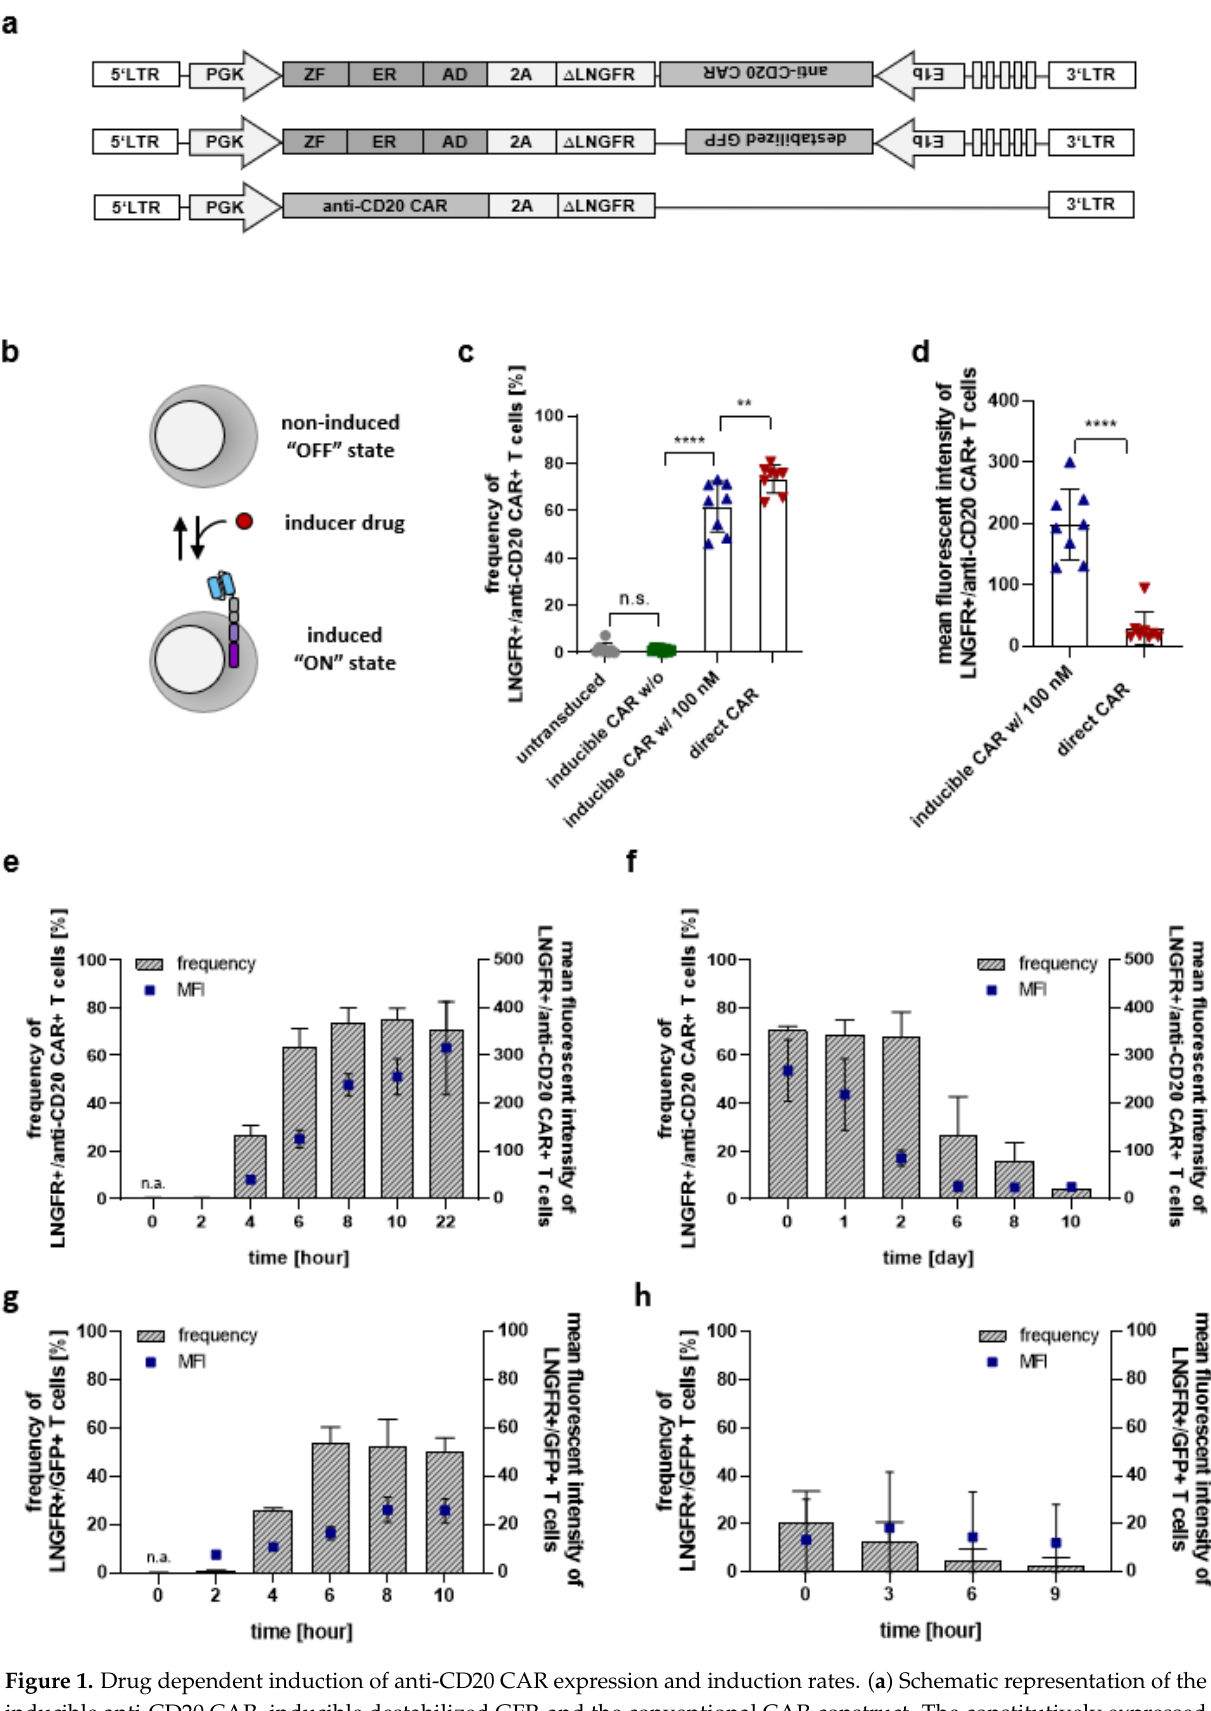
Figure 1. Drug dependent induction of anti-CD20 CAR expression and induction rates. ( a ) Schematic representation of the inducible anti-CD20 CAR, inducible destabilized GFP, and the conventional CAR construct. The constitutively